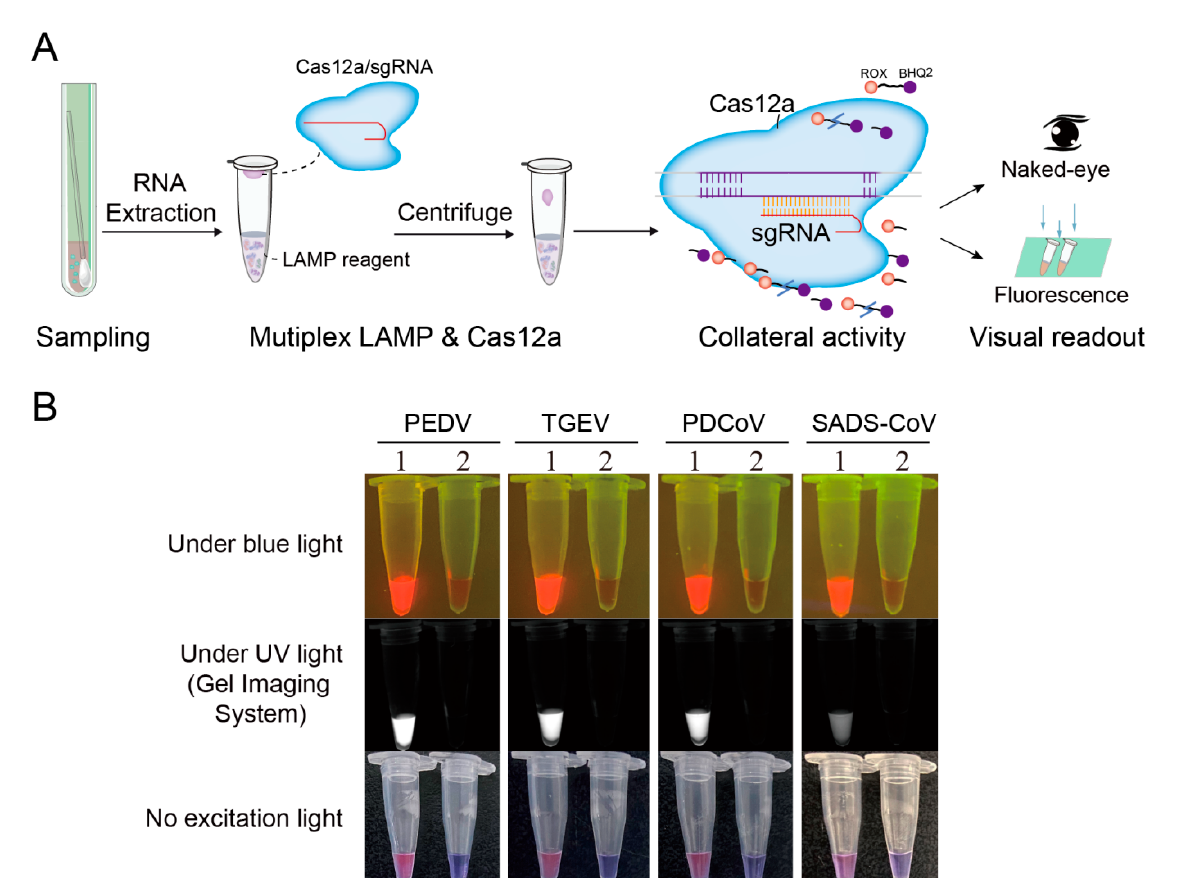
Figure 5. Establishment of one-tube multiplex LAMP-Cas12a assay for detection of four porcine diarrhea coronaviruses. ( A ) Schematic diagram experimental flow and principle of contamination- free one-tube multiplex LAMP-Cas12a assay. ( B ) Colorimetric/fluorescence readout of four porcine coronaviruses by one-tube multiplex LAMP-Cas12a assay. 1: plasmid DNA mixture of PEDV, TGEV, PDCoV, and SADS-CoV (1:1:1:1) as templates; 2: non-template control (NTC). sgRNA, small guide RNA; LAMP, loop-mediated isothermal amplification; ROX-BHQ2, ROX-labeled ssDNA-FQ reporter; No excitation light stands for white light; PEDV, porcine epidemic diarrhea virus; TGEV, transmissible gastroenteritis virus; PDCoV, porcine deltacoronavirus; SADS-CoV, swine acute diarrhea syndrome coronavirus.